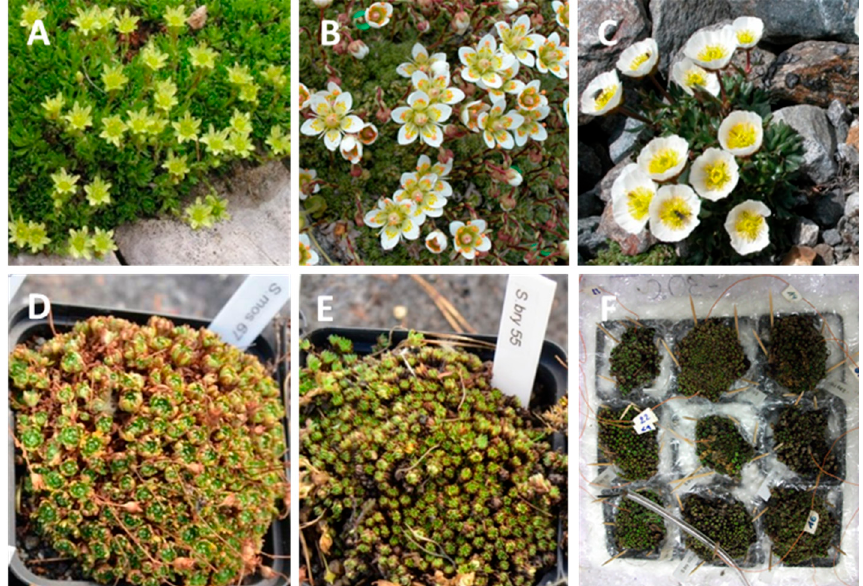
Figure 11. ( A ) Saxifraga moschata Wulfen, ( B ) Saxifraga bryoides L. and ( C ) Ranunculus glacialis L. at full bloom in summer. ( D ) S. moschata and ( E ) S. bryoides in the dormant state during winter. Cushions consist of densely arranged short-stem shoots with naked terminal buds, formed by inwardly bent foliage leaves. It is not visible from outside whether a bud is vegetative or floral. ( F ) freezing unit in experiment 2 consisting of nine potted S. bryoides individuals placed in a styrofoam box; the space between the pots is filled with foam material, and the rims of the pots are isolated with an air bubble film. Thin, brown cables are thermocouples recording temperatures within the buds; the thicker cable records the ambient temperature within the chest